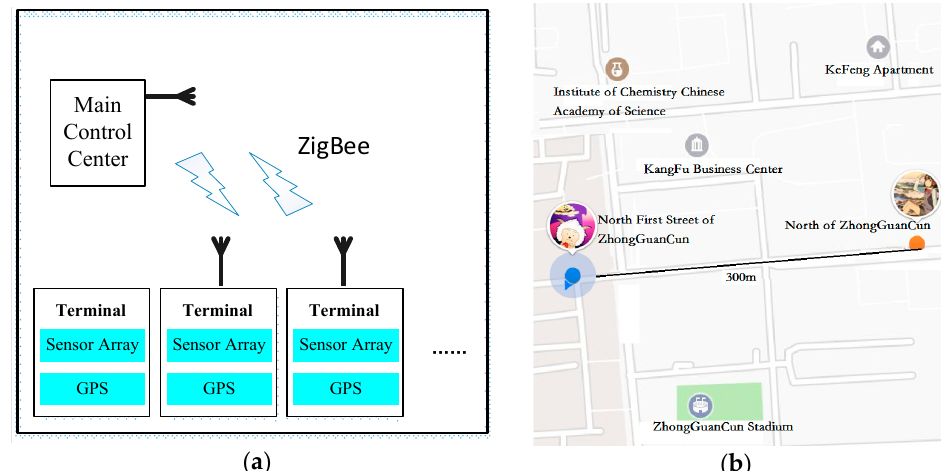
Figure 6. ( a ) Sketch map of the wireless communication module used in this study; ( b ) Position located by GPS in practical experiments.